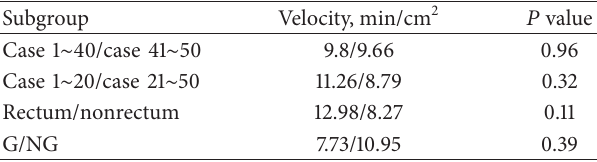
Table 3: Subgroup analysis for resection